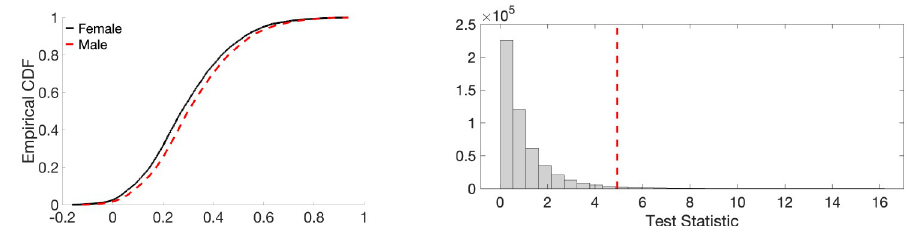
Fig 8. Left: Plot of the empirical cdfs of the average edge weights of females (in solid black line) and males (in dashed red line). Right: Histogram plot of the ETL statistic based on the resting-state fMRI dataset. The dotted red line represents the observed value of the ETL statistic.